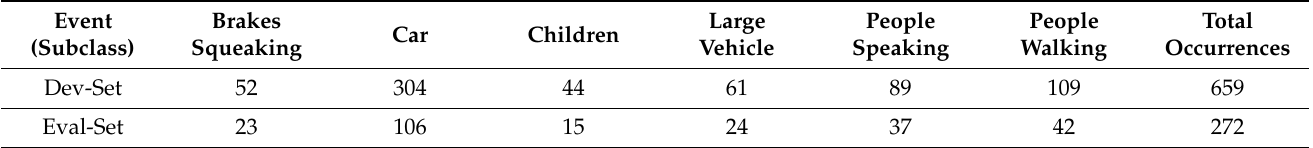
Table 2. Audio event instances per